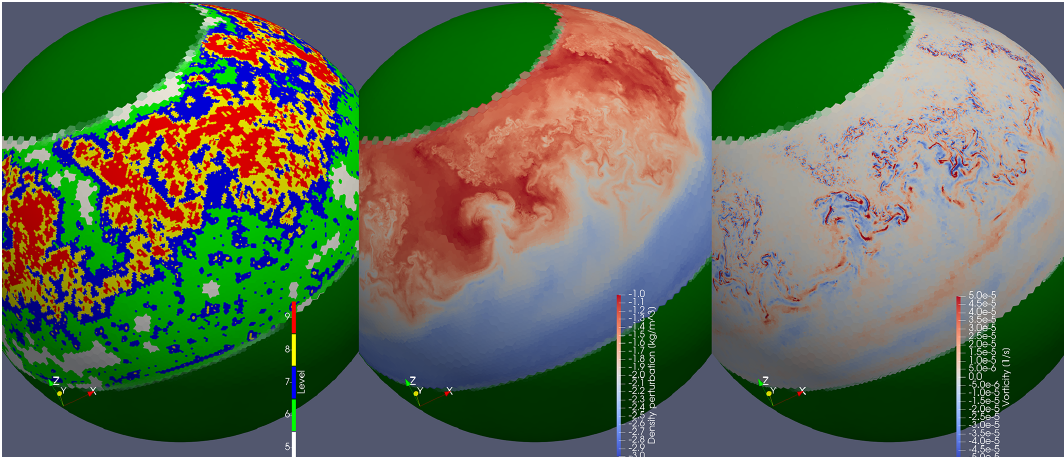
Figure 9. Higher compression run of the baroclinic jet test case with ε = 0 . 06 at 611d. Adaptive grid (left), density perturbation (centre), relative vorticity (right). Compared with Fig. 8 the grid is more localized, while still capturing the intense vorticity filaments.